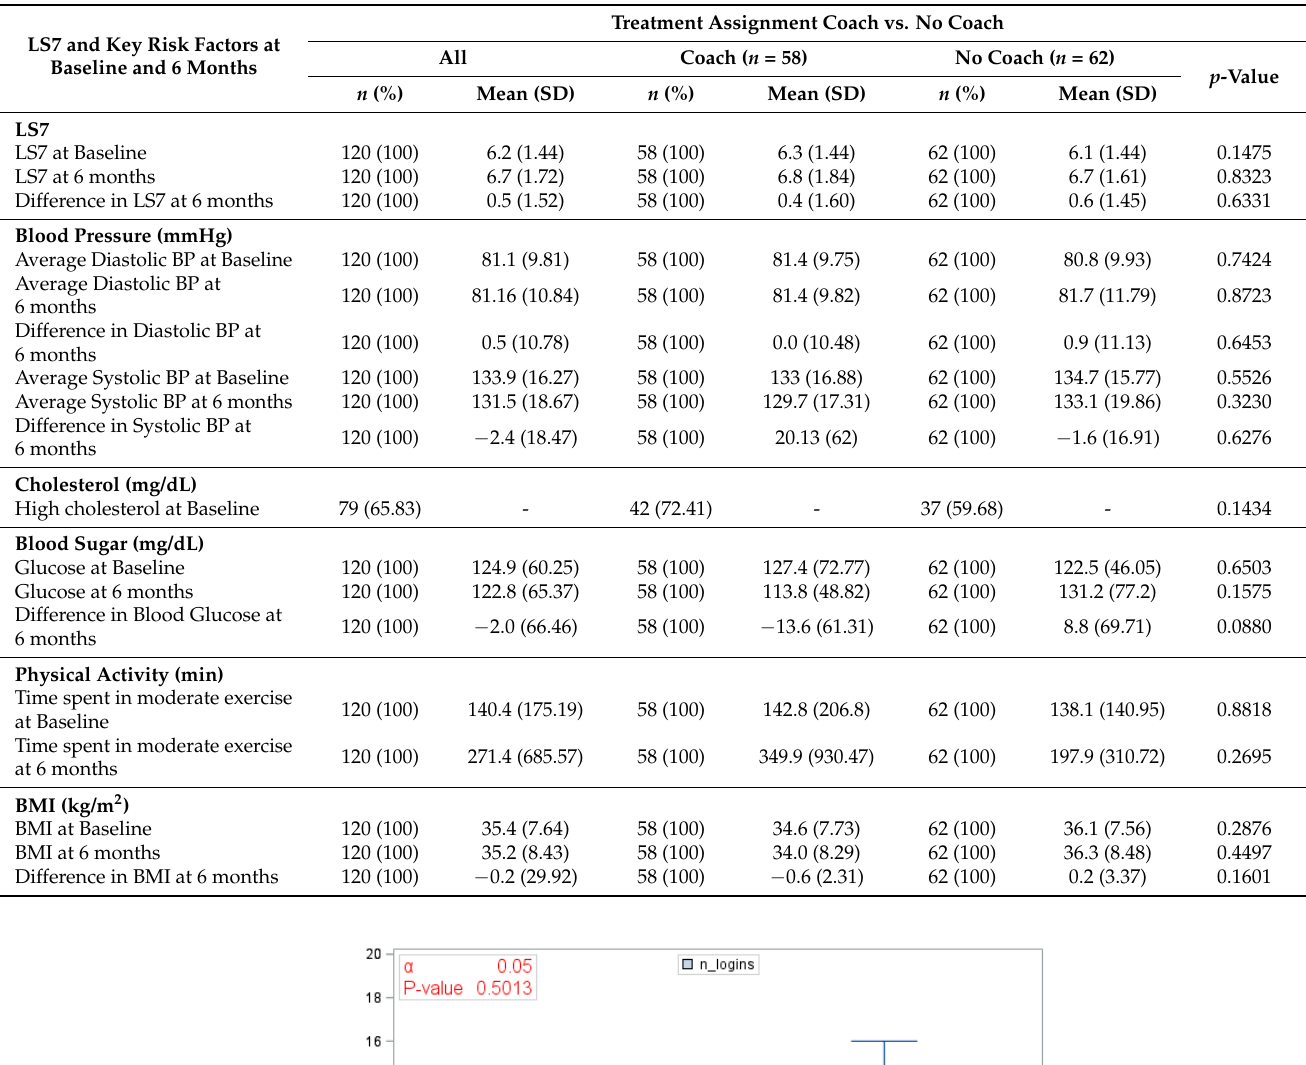
Table 2. Baseline and 6-month changes in Life’s Simple 7 (LS7).